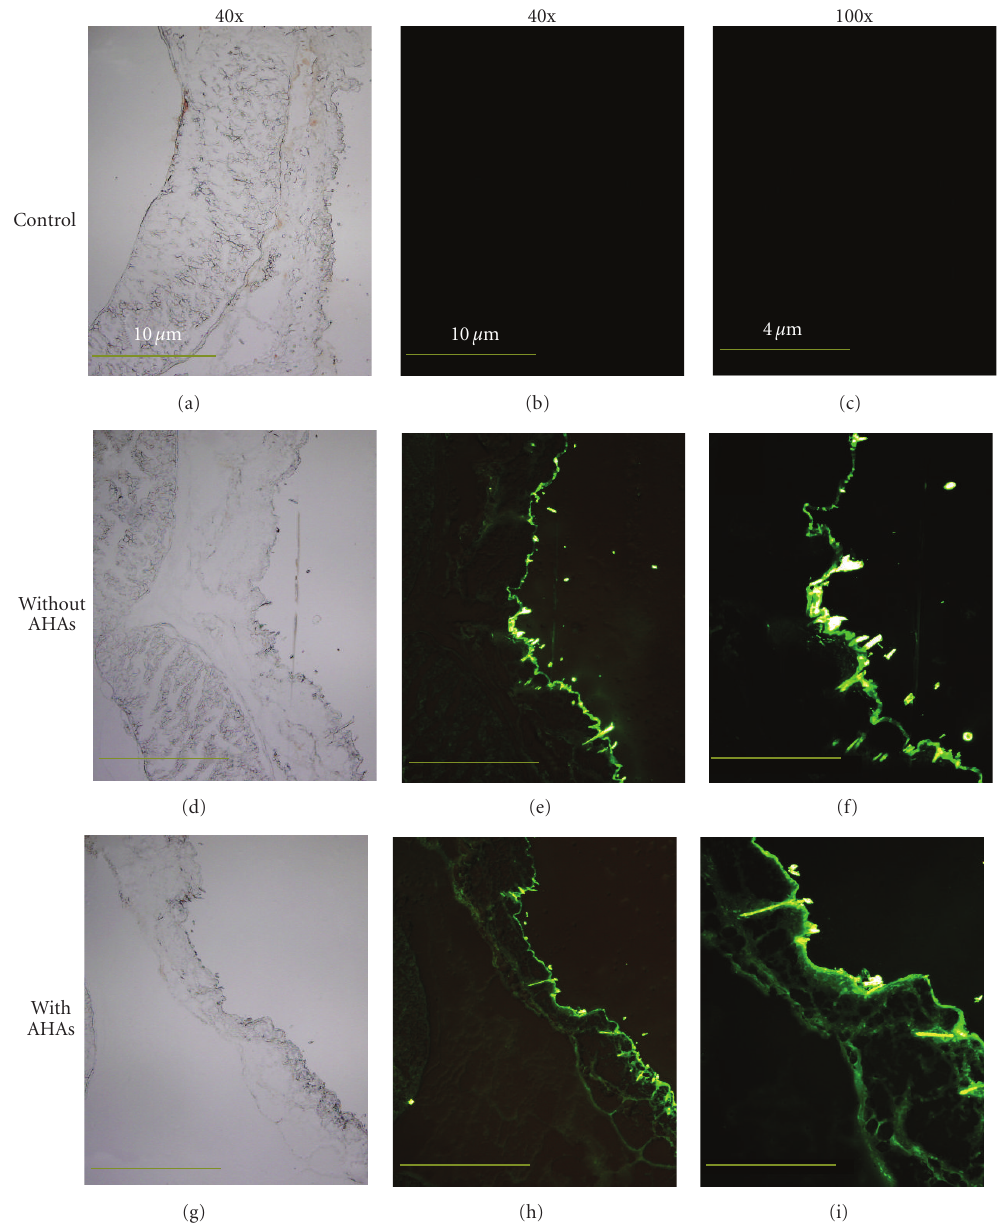
Figure 3: Fluorescence microscopic images of FITC-labeled FSCPs treated C3H/HeN mice skins. The green fluorescence is found in the follicular and epidermal areas of the vertical cross-sections of the treated skins. (a), (d), and (g) are the phase contrasts of the treated skins; (d)–(f) are groups with FITC-labeled FSCPs but without AHA pretreatment; (g)–(i) are groups with FITC-labeled FSCPs and with AHA pretreatment. (40x, 40-fold magnification; 100x, 100-fold